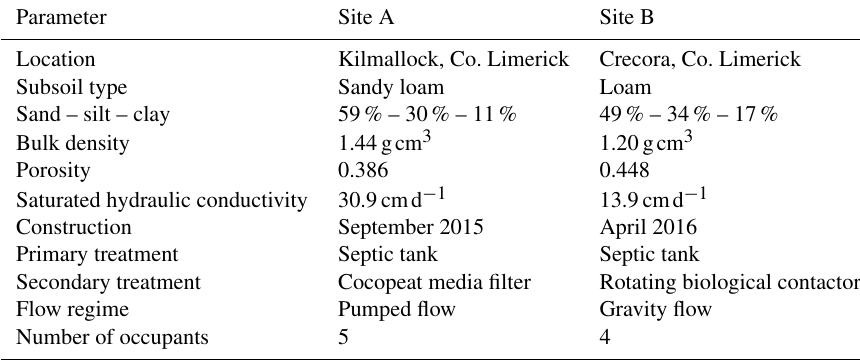
Table 1. Overview of site characteristics and installed system as reported in Knappe et al.